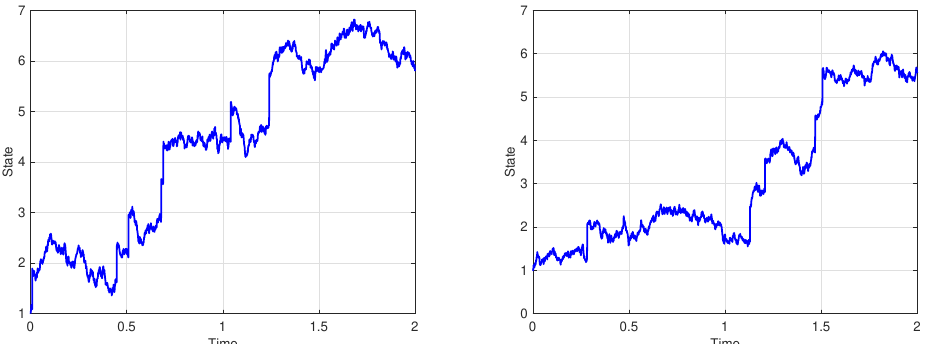
Figure 2. The two different controlled sample paths of the modified wealth process in (38) (equivalently (36)) under the Nash equilibrium ( u ∗ mean-field-type stochastic mean-variance differential